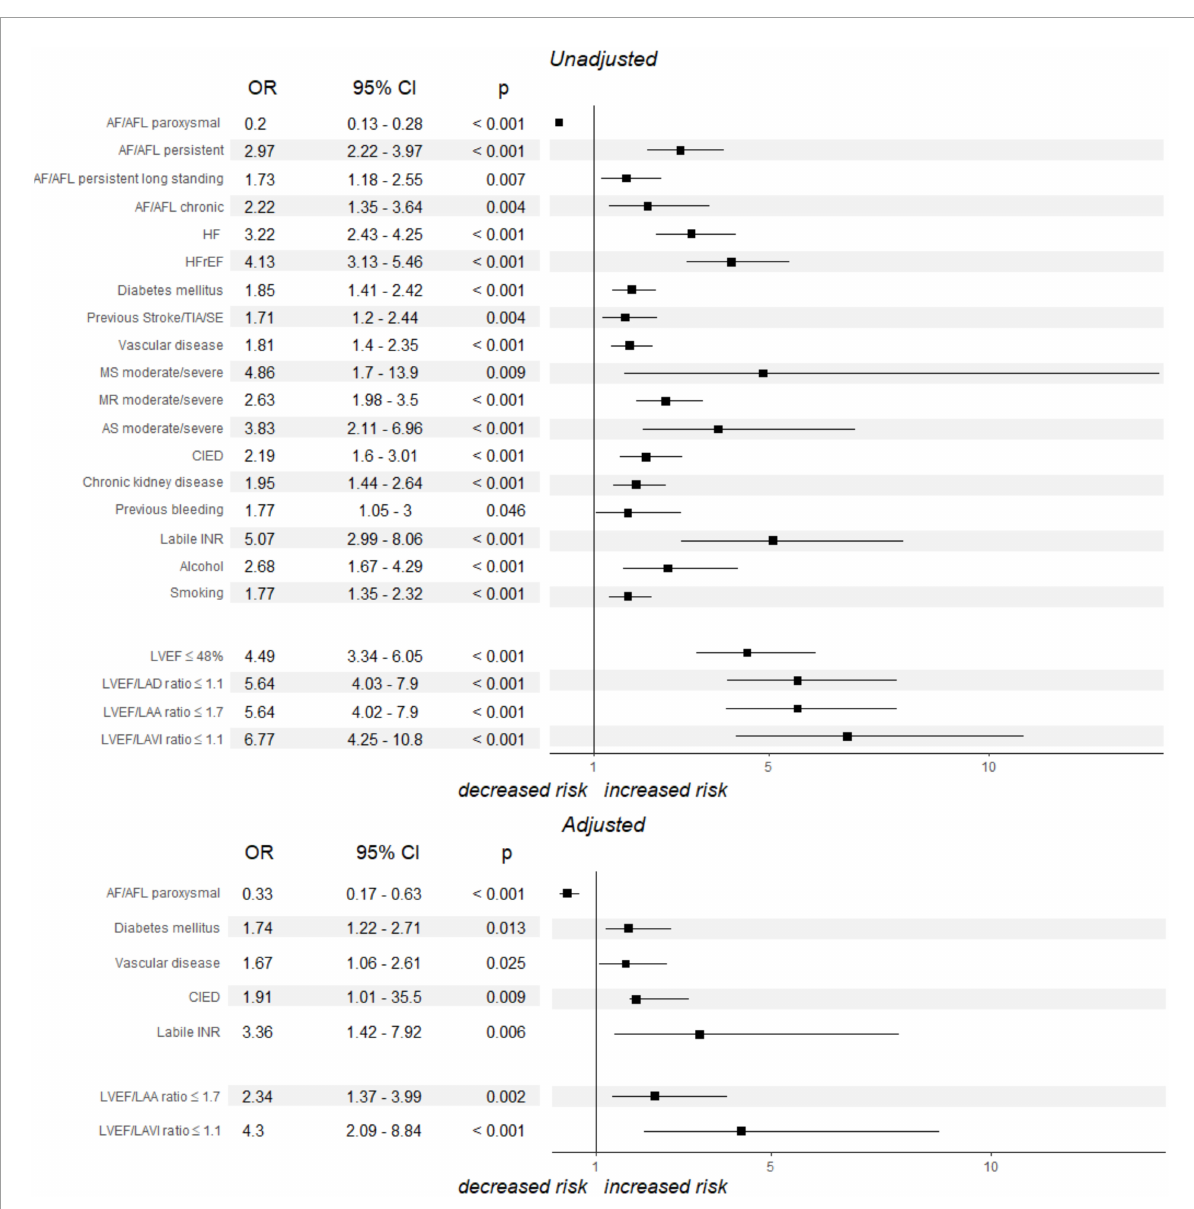
FIGURE1 Univariate and multivariate logistic regression analysis models estimating the likelihood of LAAT. p -values refer for the differences between LAAT+ and LAAT- groups. AF, atrial fibrillation; AFL, atrial flutter; AS, aortic stenosis; CI, confidence interval; CIED, cardiac implanted electrical device; HF, heart failure; HFrEF, heart failure with reduced left ventricular ejection fraction; INR, international normalized ratio; LAA, left atrial area; LAAT, left atrial appendage thrombus; LAD, left atrial diameter; LAVI, left atrial volume index; LVEF, left ventricular ejection fraction; MR, mitral regurgitation; MS, mitral stenosis; OR, odds ratio; SE, systemic embolism; TIA, transient ischemic